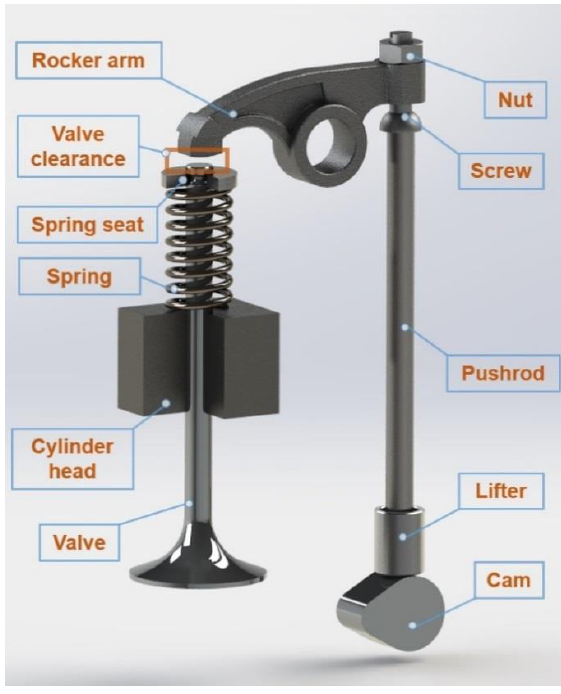
Figure 7. Sketch of valve train.